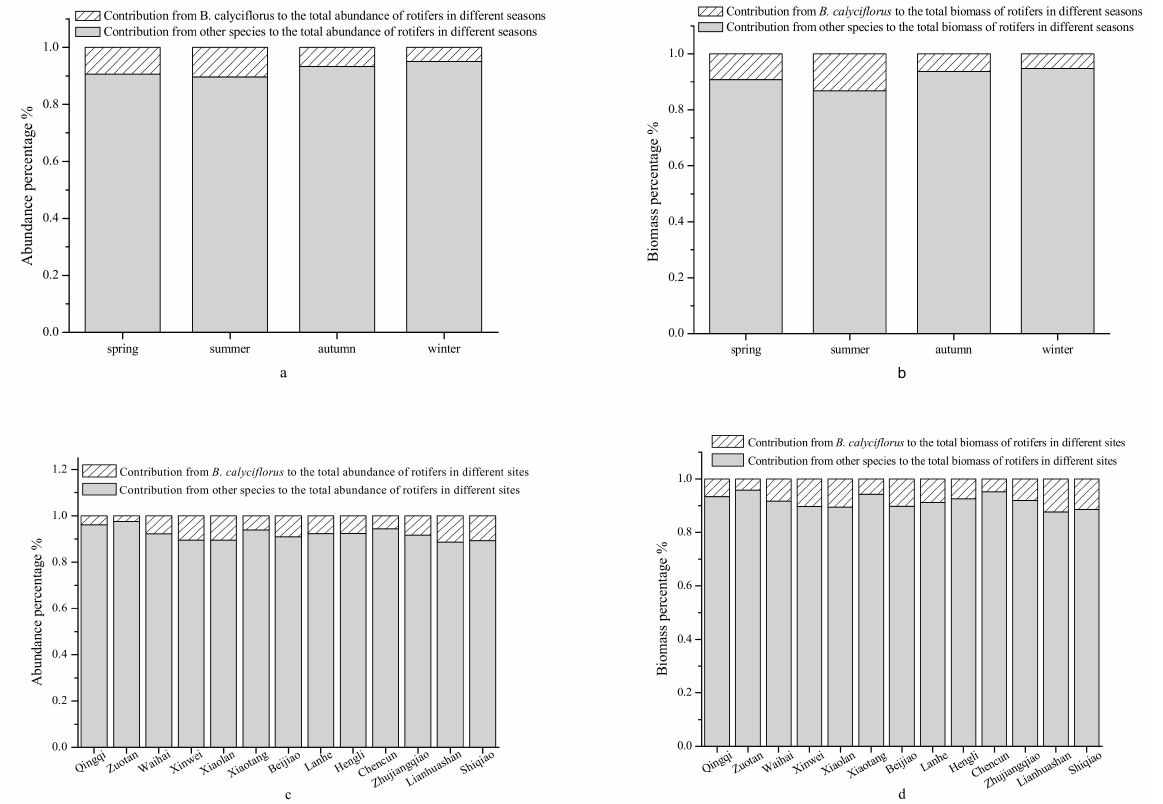
Figure 5. Contribution from Brachionus calyciflorus to the total abundance and total biomass of rotifers. ( a ) Seasonal breakdown of abundance; ( b ) seasonal breakdown of biomass; ( c ) contribution to total abundance at different sites; ( d ) contribution to total biomass at different